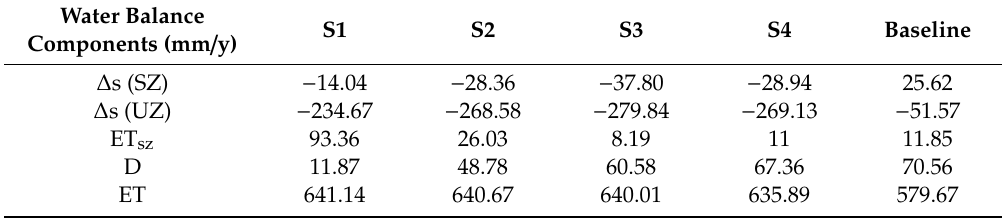
Table 4. Comparisons of the mean changes in water balance components from Feb 2011 to Feb 2015.